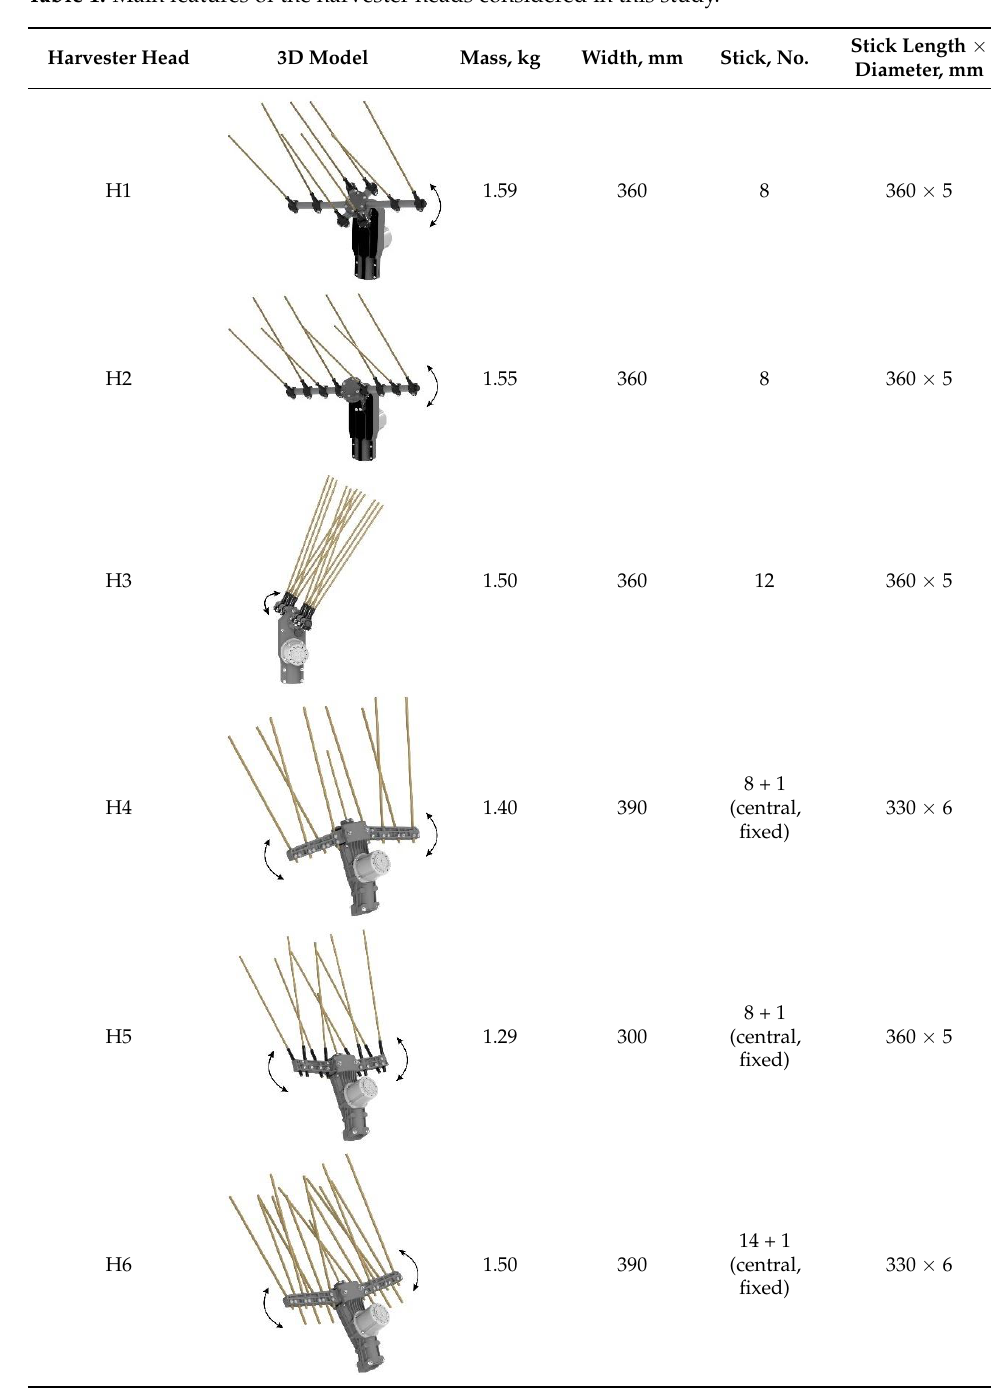
Table 2. Main features of the rods considered in this study.